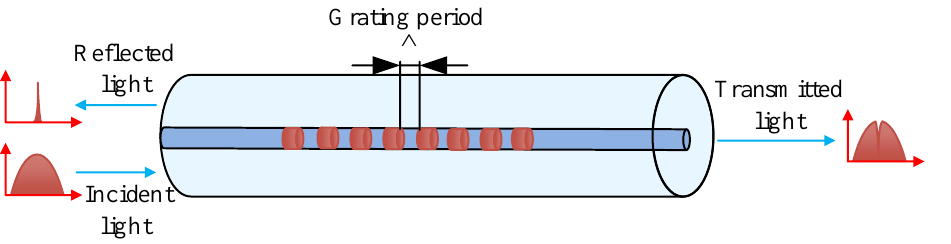
Figure 6. Principle of FBG sensor.